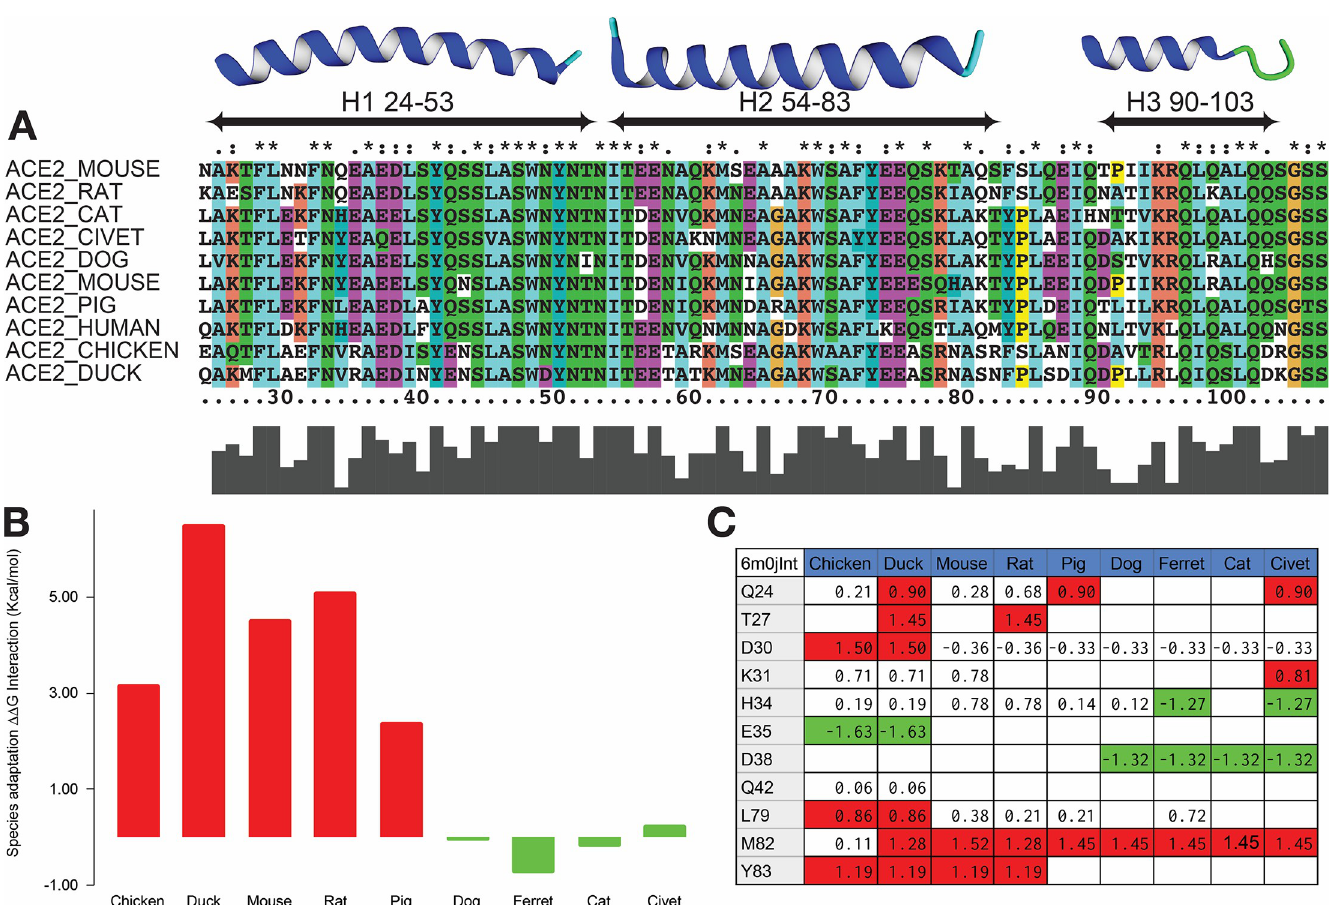
Fig 2. Binding affinities of animal species. (A) ACE2 full sequence alignment of the selected species for the binding region to the S protein (B) Global ΔΔ G interaction for different species by adding single residue contributions with respect to hACE2. Green bars for species susceptible to be infected, red bars for species not infected. (C) Per-residue interaction ΔΔ G values in kcal/mol with respect to the hACE2 residues. We don’t show the results for K353 in this table since it is not on the helical interface and it is only mutated to His in mice.